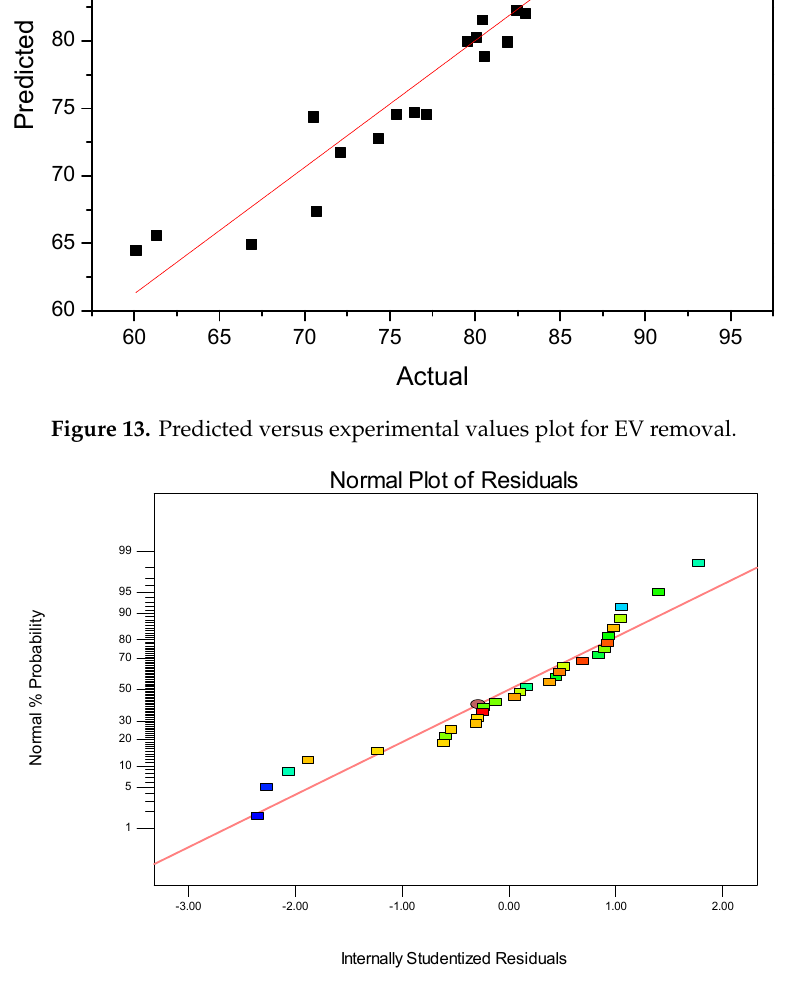
Figure 14. Normal probability plot of residuals.